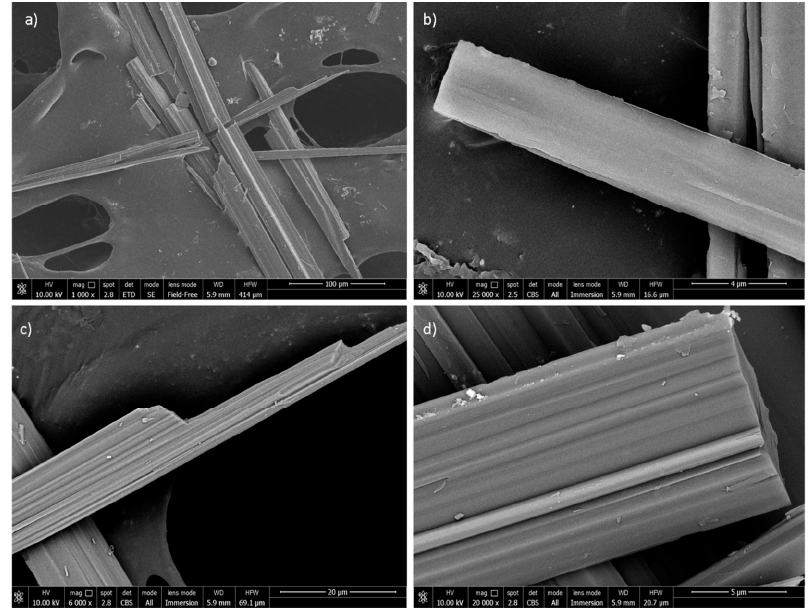
Figure 3. A gallery of field emission gun ‐ Scanning electron microscopy (FEG ‐ SEM) pictures of